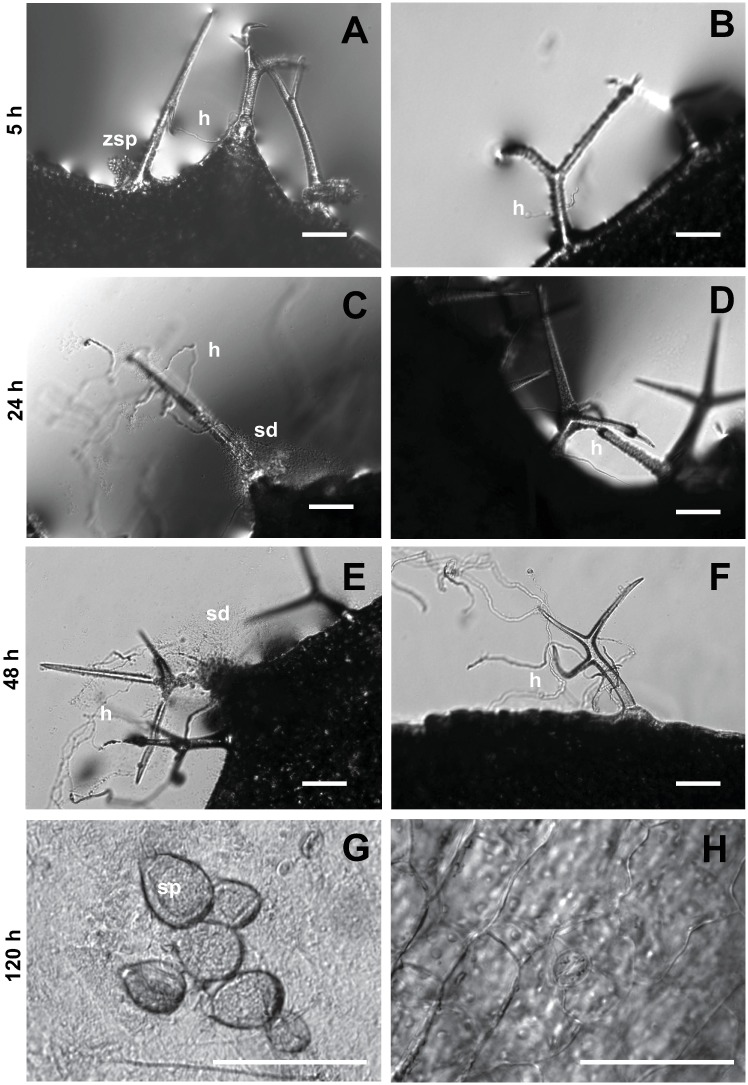
Microscopy of effects of zoospore free fluid (ZFF) on Arabidopsis (Col-0) responses to Phytophthora nicotianae zoospores.Individual cauline leaves were flooded in ZFF (A, C, E, and G) or sterile distilled water (SDW) (B, D, F and H) containing zoospores at 1,600 /ml and observed at different exposure time. Bars = 50 μm. Letters: h = hypha or hyphae, sd = substance discharge from plant tissues, sp = sporangia, zsp = zoospores.